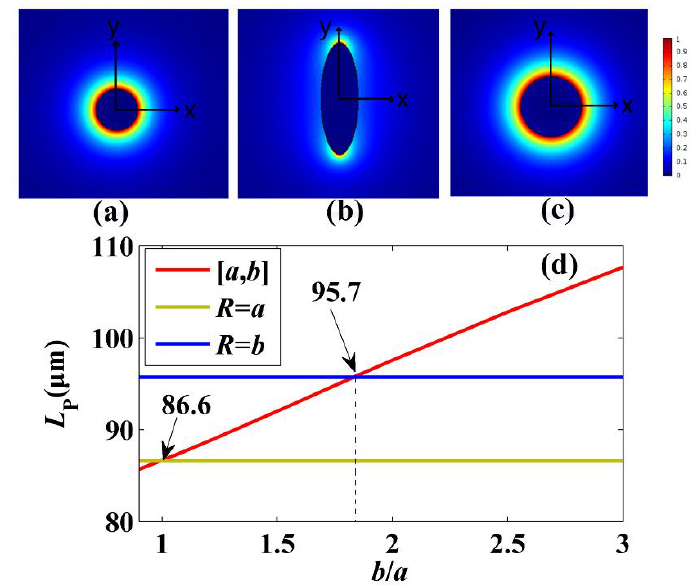
Figure 7. Normalized energy distributions for three GP modes. ( a ) R = a = 1 μm, ( b ) a = 1 μm and b = 3 μm, ( c ) R = b = 3 μm, ( d ) comparison of the propagation length. The other parameters are u c = 0.5 eV, ε 1 = 2.25, ε 2 = 1, a = 1 μm, and f 0 = 3 THz.